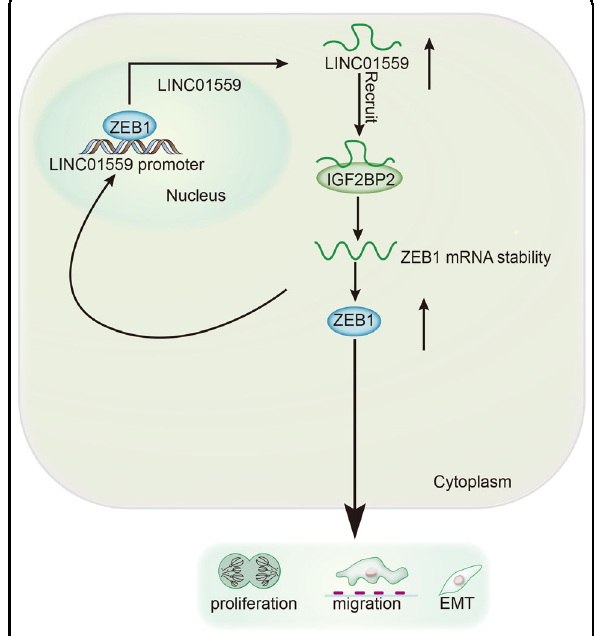
Fig. 7 Concept map illustrates the function and regulatory mechanism of LINC01559 in GC